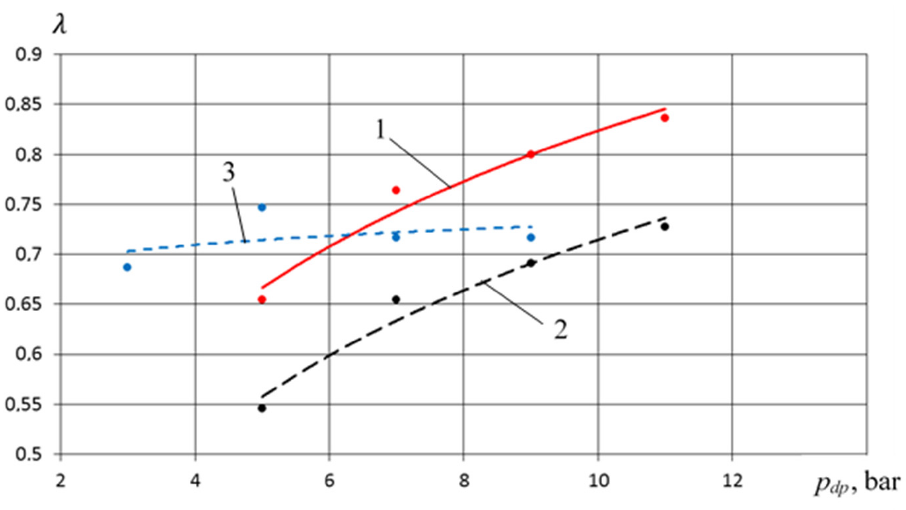
Figure 28. Dependence of the flow coefficient of the compressor section on the discharge pres- sure of the pump section (1—PHPM with step-type gap seals, 2—PHPM with smooth gap seals, 3—Crosshead-free